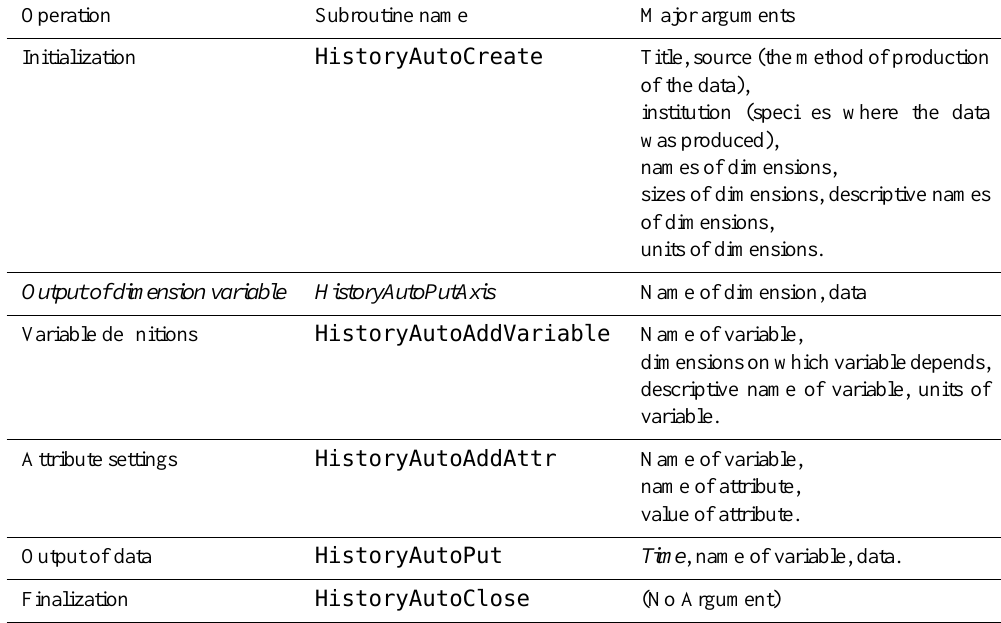
Table 2. Data input/output interface for massive models, where output data are separately stored into multiple files so that each file contains an output variable. Only major subroutines are shown. The items with an italic font do not exist in the interface shown in Table